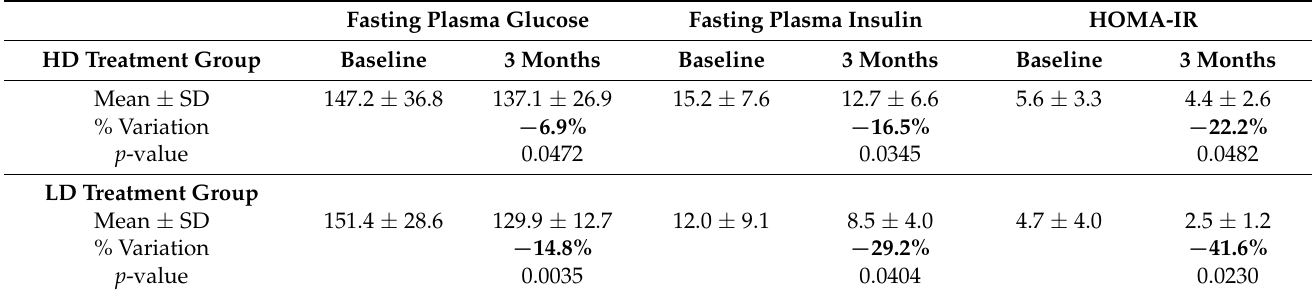
Table 3. Effects of low and high doses of thinned nectarines on glycemic parameters at baseline and after 3 months.